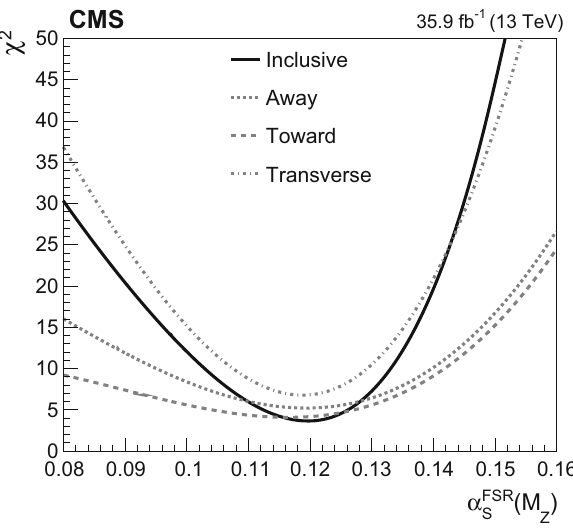
Fig. 26 Scan of the χ 2 as a function of the value of α FSR employed in the Pw+Py8 simulation, when the inclusive p T or the p T distribution measured in different regions is used. The curves result from a fourth-order polynomial interpolation between the simulated α FSR ( M ) points Z S resonant processes are enabled. The envelope of the dif- ferences is considered as a systematic